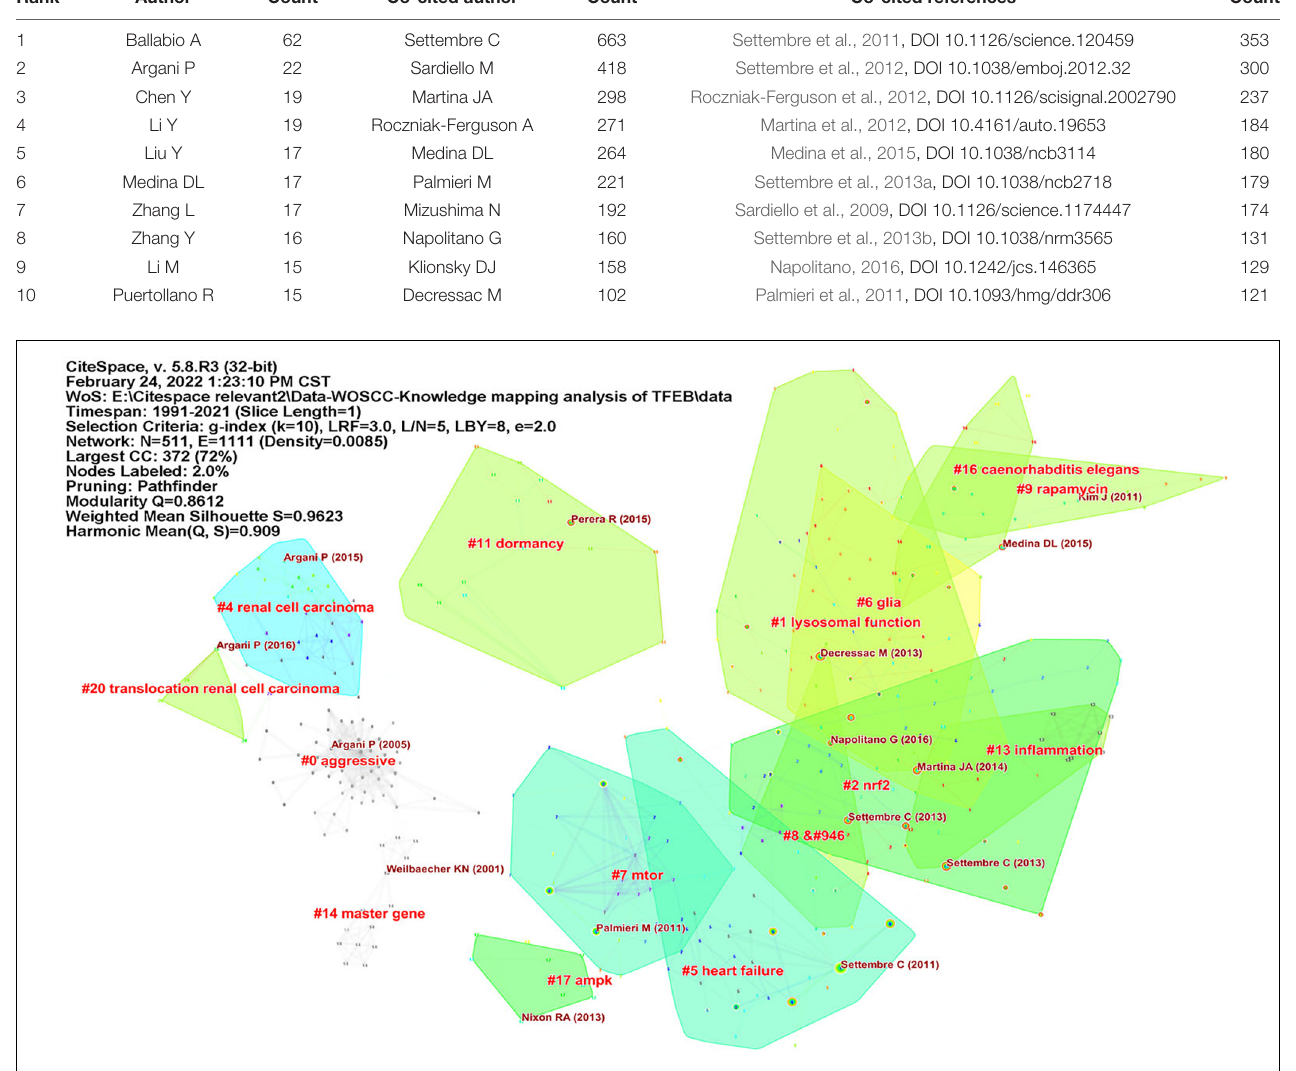
FIGURE 3 | The reference co-citation clusters map for publications in TFEB